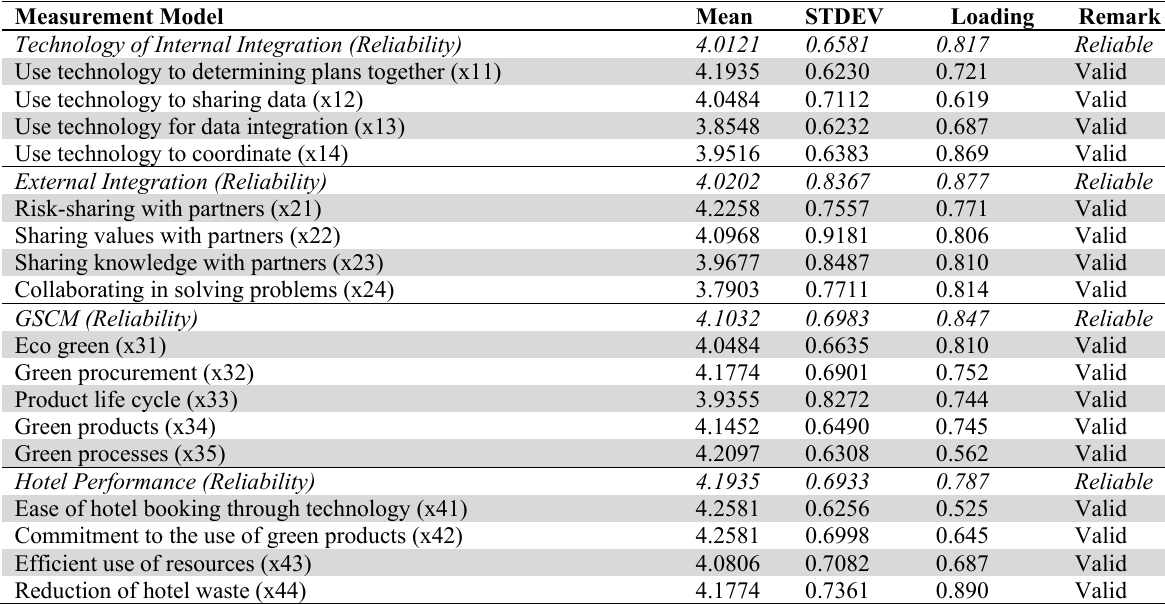
Model Measurement Measurement Model Mean STDEV